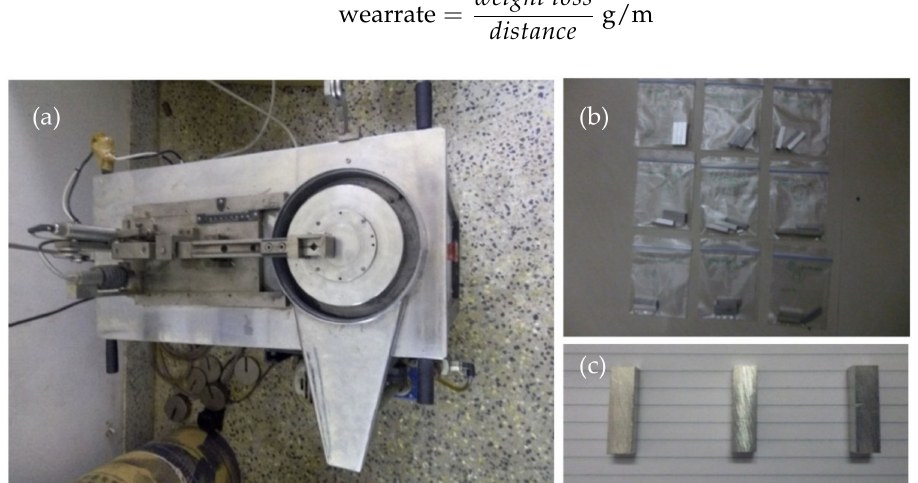
Figure 2. ( a ) Pin-on-disc wear tester setup, ( b ) specimens prepared for wear test, and ( c ) specimens after wear